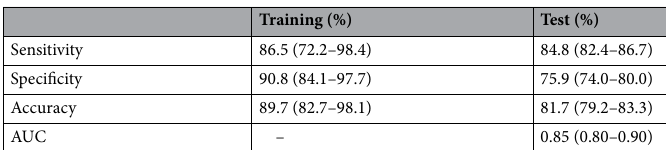
Table 8. Assessment of the predictive performance of the predictive model for training and testing data in multi-region radiomics analysis with the synthetic minority over-sampling technique. AUC area under the